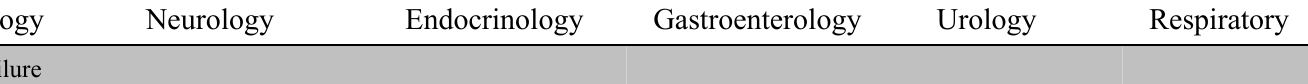
Applications of electronic